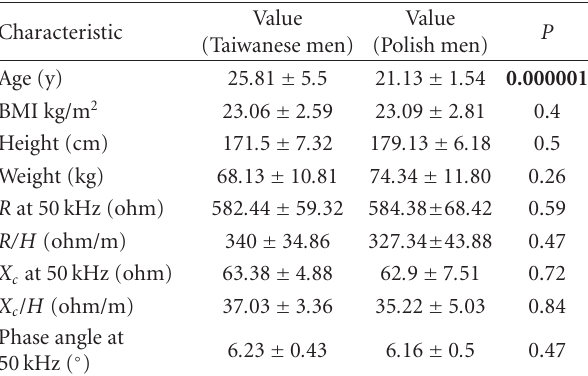
Table 3: Baseline characteristics of the Taiwanese and Polish college female students 1 .